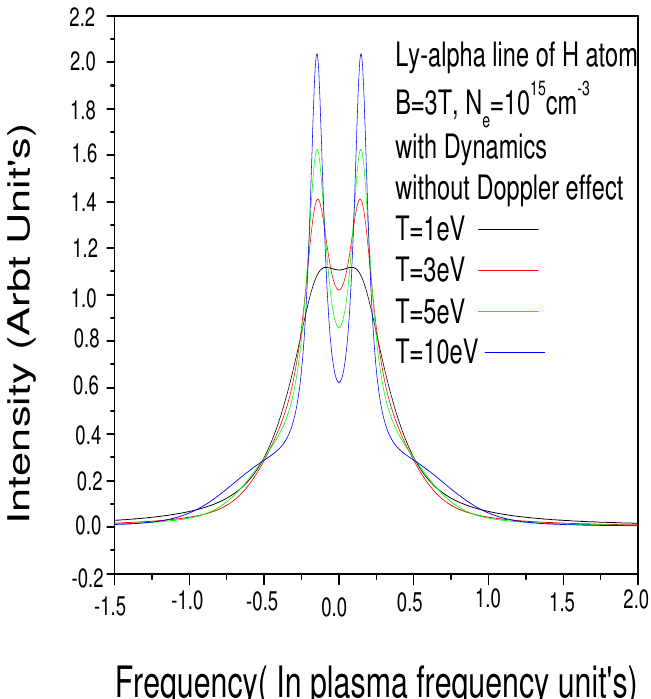
Figure 6. Lyman Alpha line in the hydrogen plasma: The electron temperature effect on the line with the MSE effect without the Doppler effect and fine structure